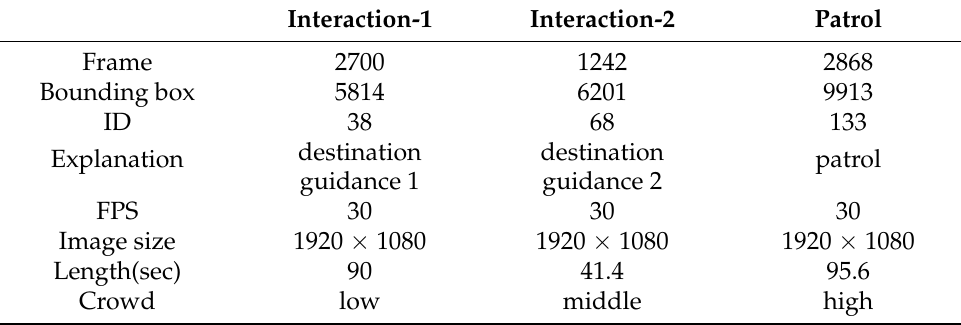
Table 1. The details of benchmark sets built on three different